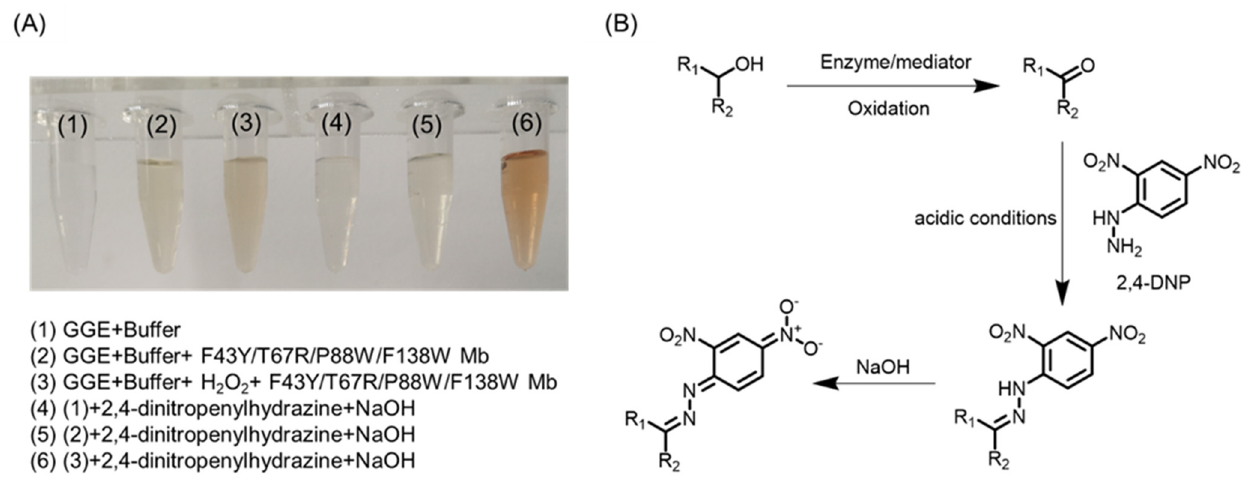
Figure 6. ( A ) Visual appearance of GGE (2.0 mM) oxidation in the absence (1) and presence (2–3) of F43Y/T67R/P88W/F138W Mb (5 µ M) and H 2 O 2 (2.0 mM) (3) for 10 min. After the reactions (1), (2), and (3) mixed with 2,4-dinitropenylhydrazine (2,4-DNP, 0.3 mM) for 15 min, the visual appearance of reactions in the presence (4–6) of NaOH (0.5 mM). ( B ) Reaction overview of 2,4-DNP with carbonyl groups [44].